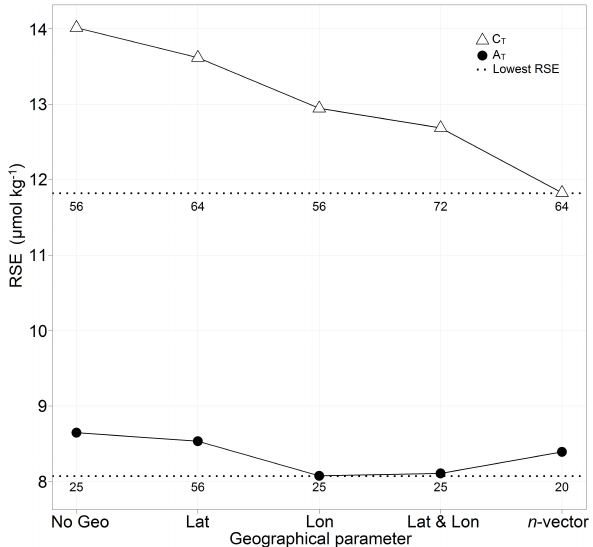
Fig. 8. Skill of optimal SOMLO models with geographical con- straints. Numbers below dashed line represent the optimal number of neurons.